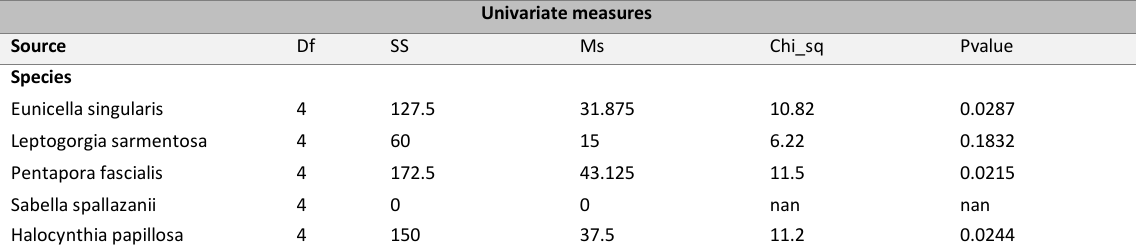
Table 6: Results of multivariate NP-Manova testing the interactive effects of geographical sector and site (nested in geographical sector) on the presence/absence assemblage. Sites tested: (AGM1 vs AGM2) vs (AGD2 vs AGD3) vs (VLR1 vs VLR2) vs (GRU1 vs GRU2 vs GRU3) vs (LEU1 vs LEU2). Significant